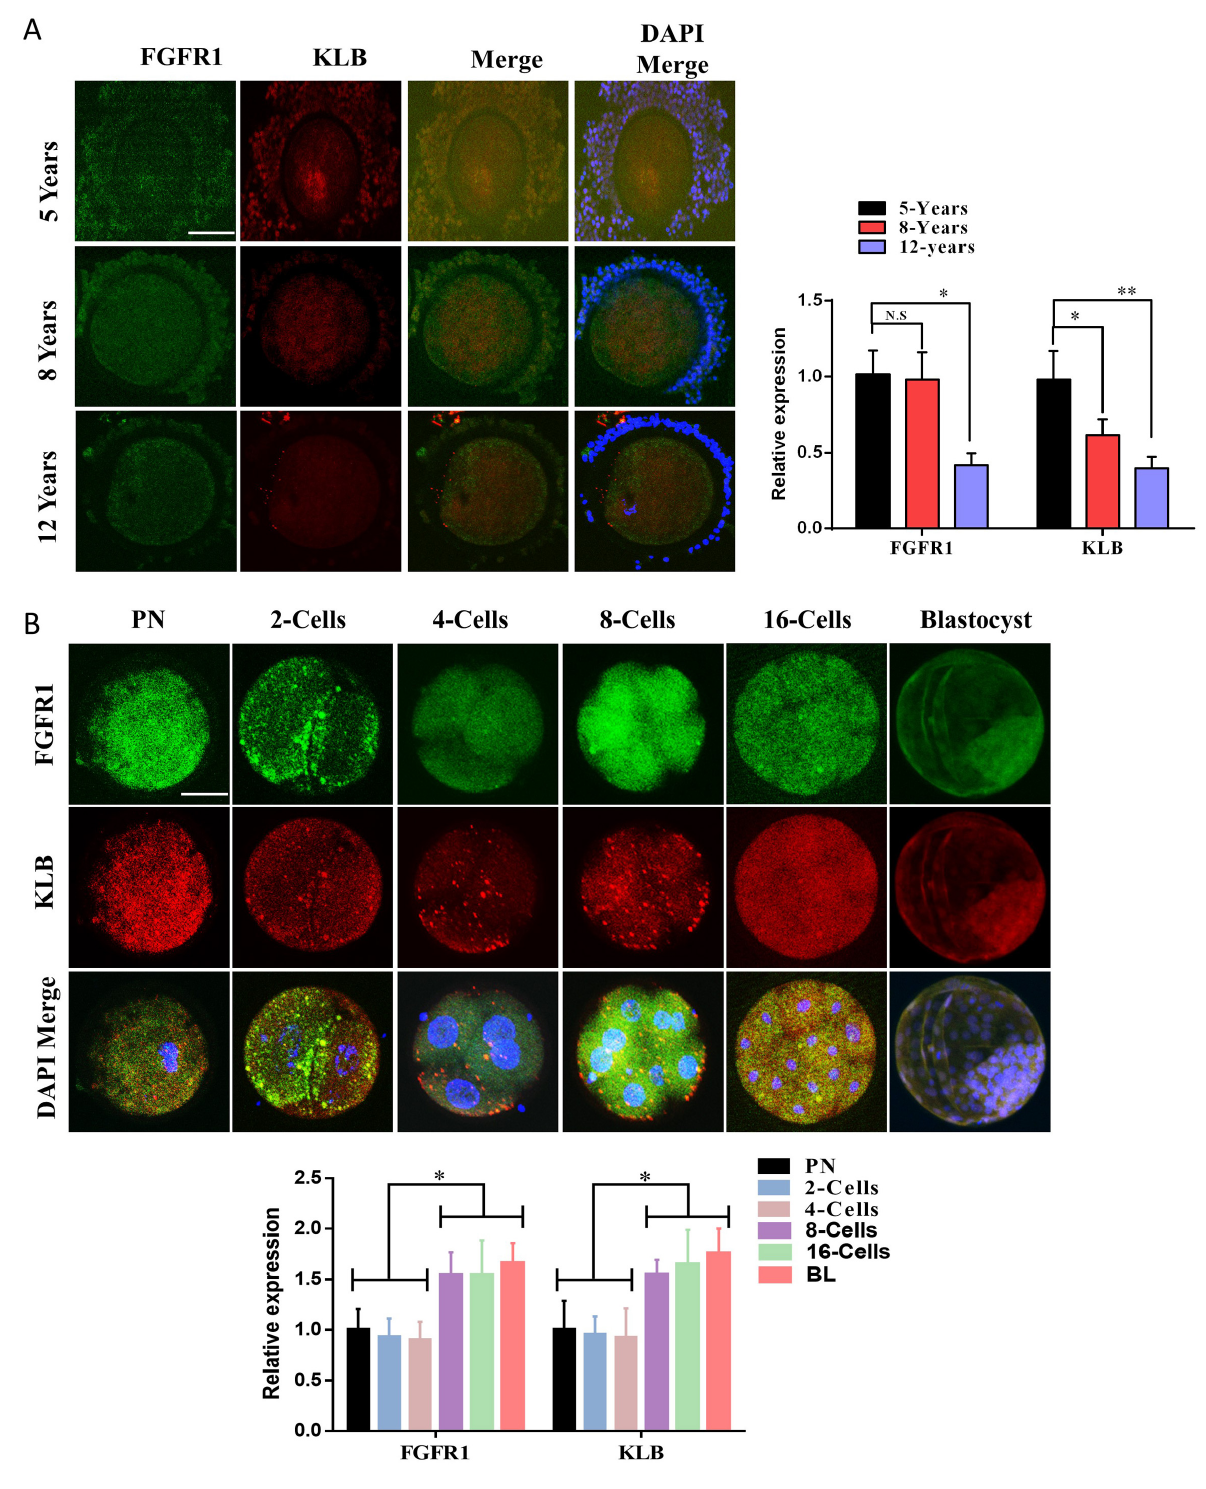
Figure 1. β -Klotho and FGFR1 proteins in bovine oocyte and early embryos. ( A ) The immunofluorescence based FGFR1 and β -Klotho proteins from Pronuclear (PN) stage to day-8 bovine blastocyst 10 per each sample), MII oocyte (20 per each sample), 2-cell embryo (20 per each sample), the 3.5-day embryo (10 per each sample) and day-8 blastocyst stages (5 per each sample and Bar = 100 µ m). ( B ) Immunofluorescence expressions of FGFR1 and β -Klotho in bovine cumulus-oocyte complexes obtained from 5 years, 8 years, and 12 years old Hanwoo (Korea native) cows. The experiments were repeated 3 times, and the data are shown here as a mean ± S.E.M. N.S, not significant. Significance: * = p < 0.05, and ** = p < 0.01 and Bar = 100 µ